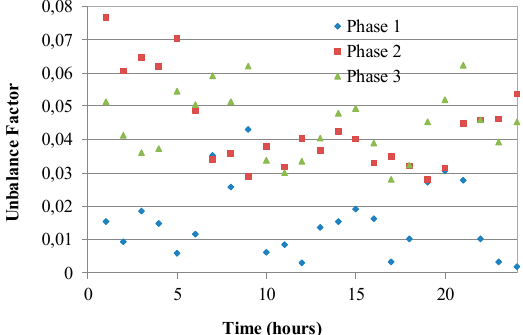
Figure 11. Unbalance factor after applying the proposed method for Bariloche, Argentina.